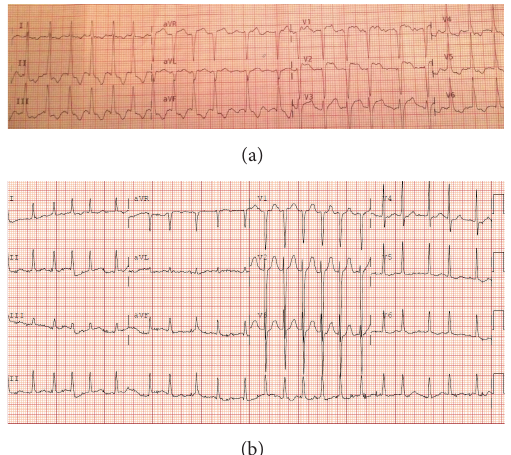
Figure 1: (a) Electrocardiogram from EMS showing ST elevation in V1–V3withSTdepressionsinV4–V6,I,II,II,andAVFinthesetting of chest pain. (b) Electrocardiogram 3 days later with resolution of ST